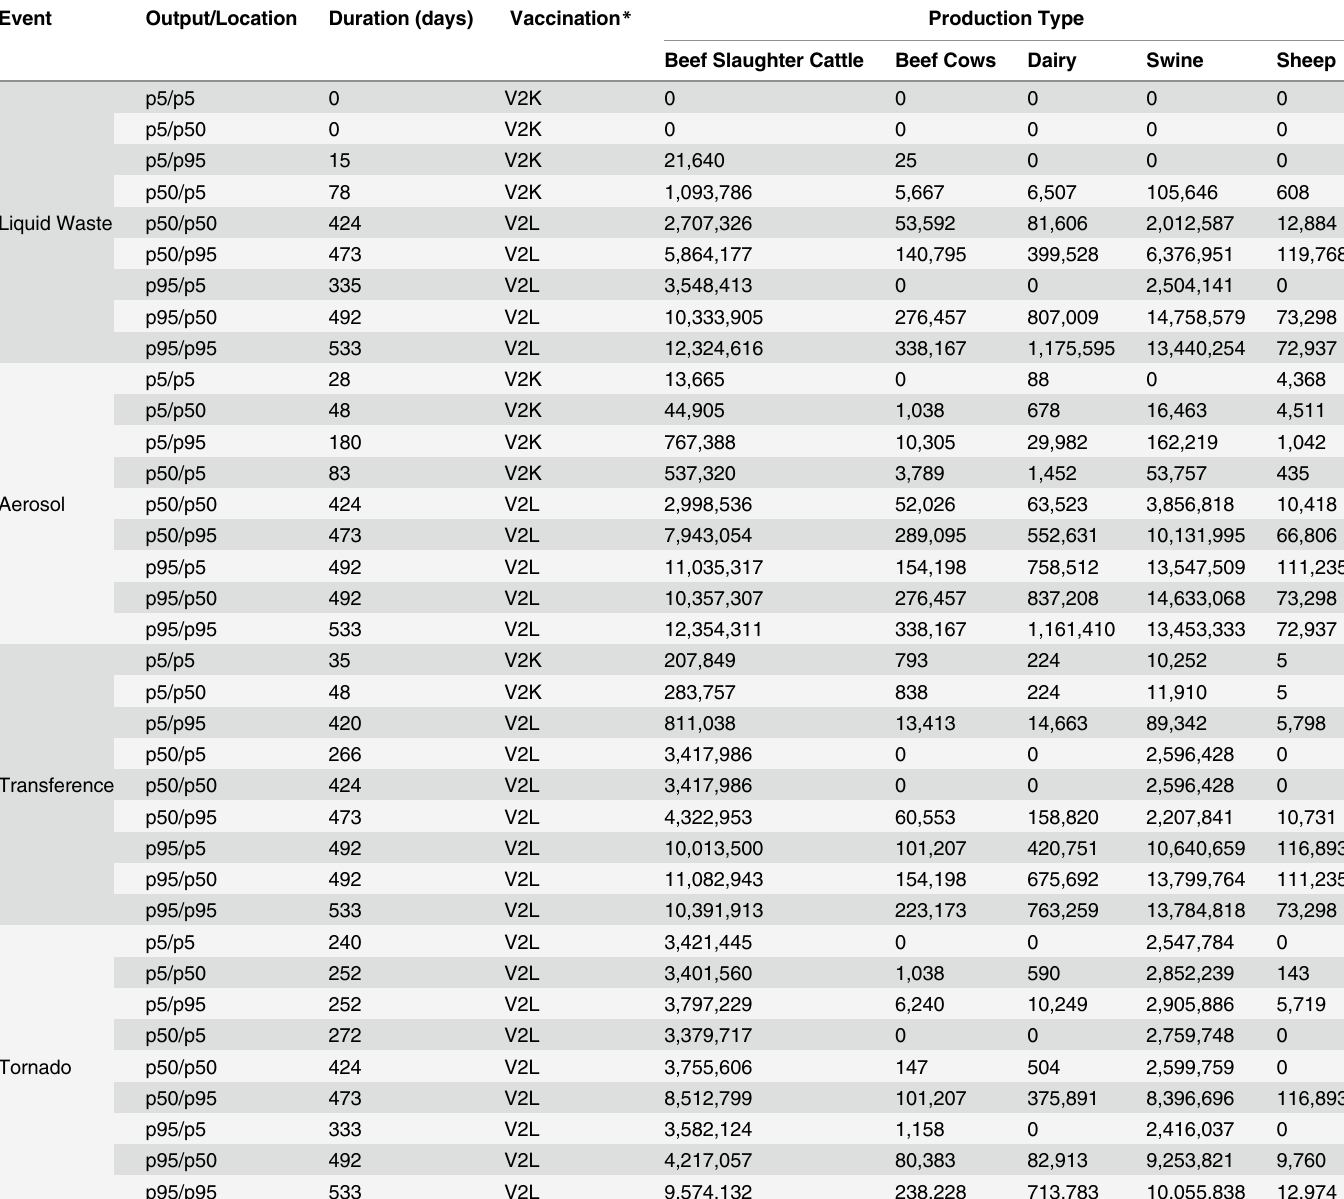
Table 3. Number of Animals Depopulated by Production Type and Duration of FMD